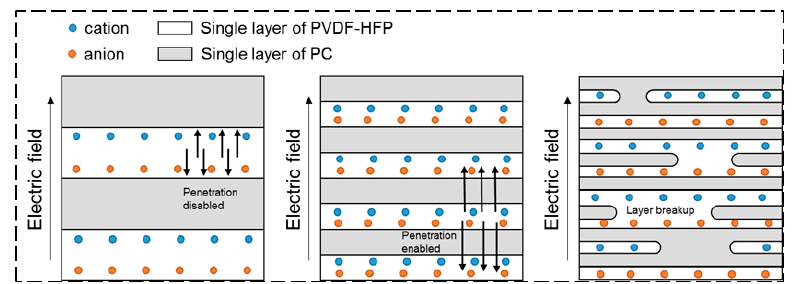
Figure 7. Schematic illustration of the interfacial polarization of space charges in coextruded PVDF-HFP/PC films varying layer thickness and structure under an external electric field.